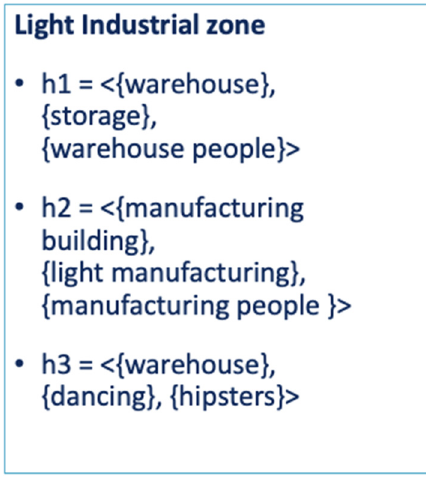
Figure 5. Formemes in H.